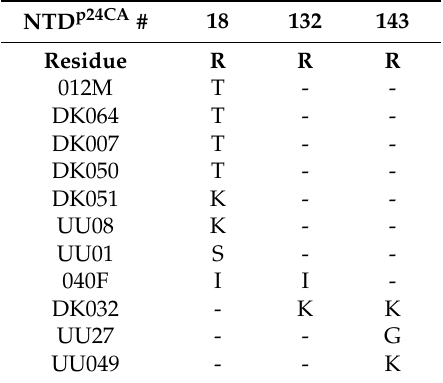
Table 2. NTD p24CA Amino Acid Distribution of Key Residues Interacting with Ank GAG 1D4 in 11 Individuals.